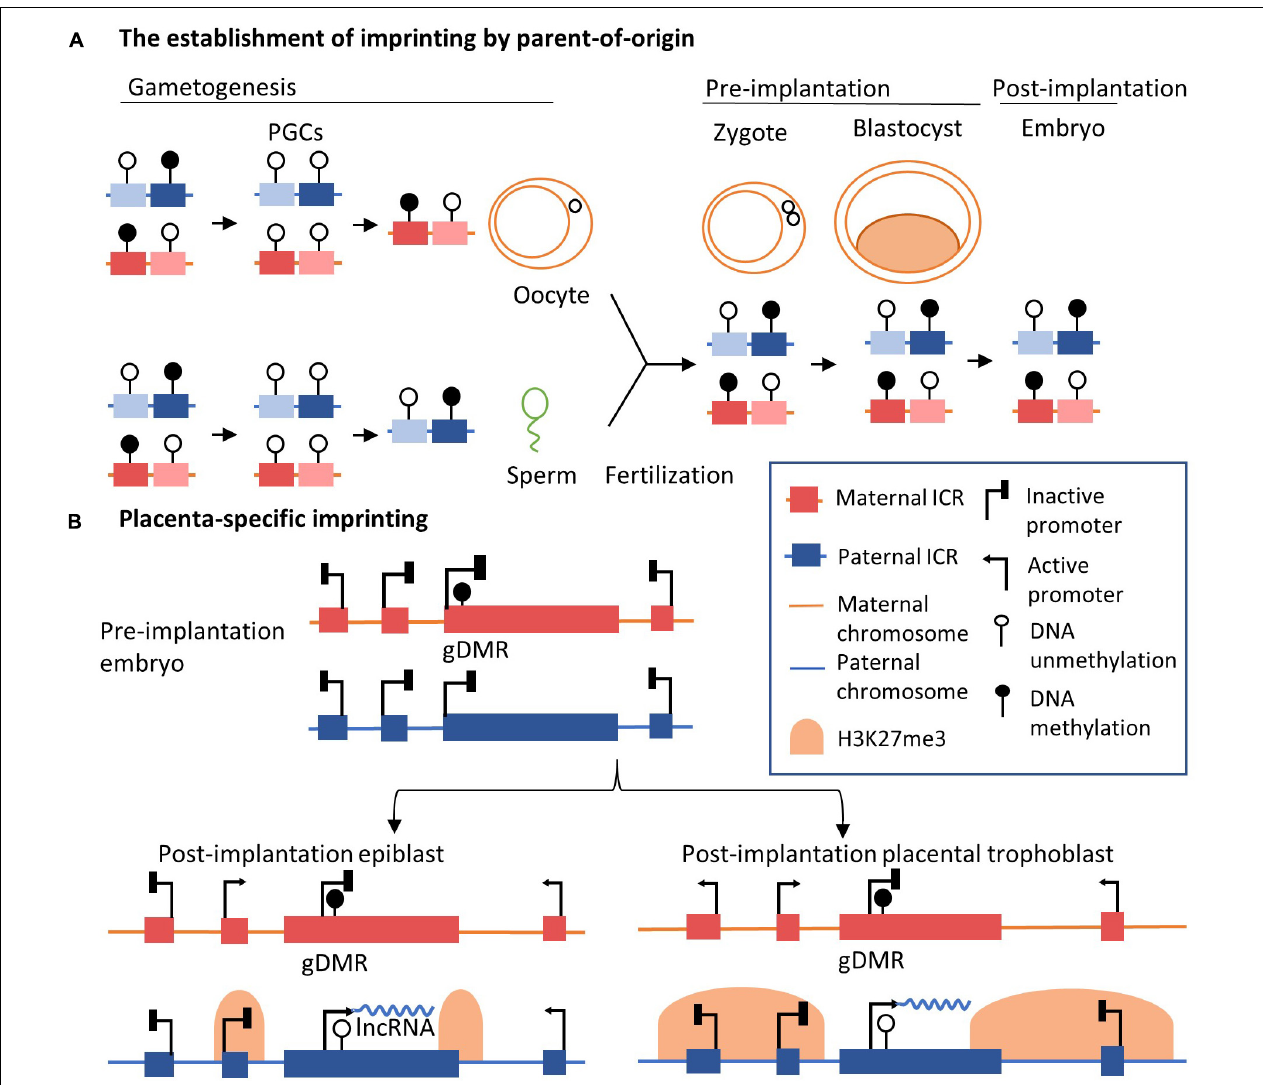
FIGURE 1 | Genomic basis of the regulation of imprinting clusters. (A) The inheritance of allele-specific imprinting epigenetic marks across generations. In the early primordial germ cells, epigenetic modifications are erased at a genomic scale before the formation of germline cells. In the germline, parent-of-origin DNA methylation is established, shown as gDMRs. After fertilization and the formation of the zygote, the gDMRs are further maintained. Established imprinting patterns are maintained in blastocyte and somatic cells in adult tissues. (B) Imprinting in epiblast and placenta in imprinting loci, such as the Kcnq1ot1/Kcnq1 or Airn/Igf2r loci, is shown. In pre-implantation embryos, DNA methylation is inherited in the gDMR on the maternal allele, such as KvDMR1 of the Kcnq1ot1/Kcnq1 imprinting cluster. After implantation, the expression of lncRNA on the maternal allele is repressed by DNA methylation in gDMR, allowing the expression of neighbor genes. On the contrary, lncRNA is expressed from the paternal allele, inducing the spreading of H3K27me3 modifications in adjacent regions in the embryonic lineage (epiblast). In extra-embryonic lineage (placental trophoblast), the extended scale of H3K27me3 marks is longer than that seen in embryonic cells. Adjacent genes further away are also silenced on the paternal allele, indicating placenta-specific imprinting, such as Slc22a18 and Tssc4 genes in the Kcnq1ot1/Kcnq1 imprinting cluster. For simplicity, specific gene names are not